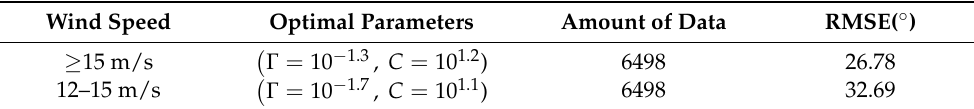
Table 5. Results of wind speed ≥ 15 m/s and 12–15 m/s after controlling the amount of data. Wind